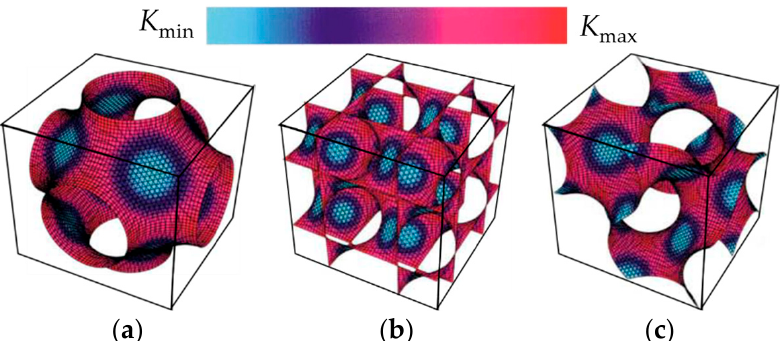
Figure 2 . Distributions of the Gaussian curvature at each point of minimal surfaces [20]: ( a ) Primitive; ( b ) Diamond; ( c ) Gyroid.